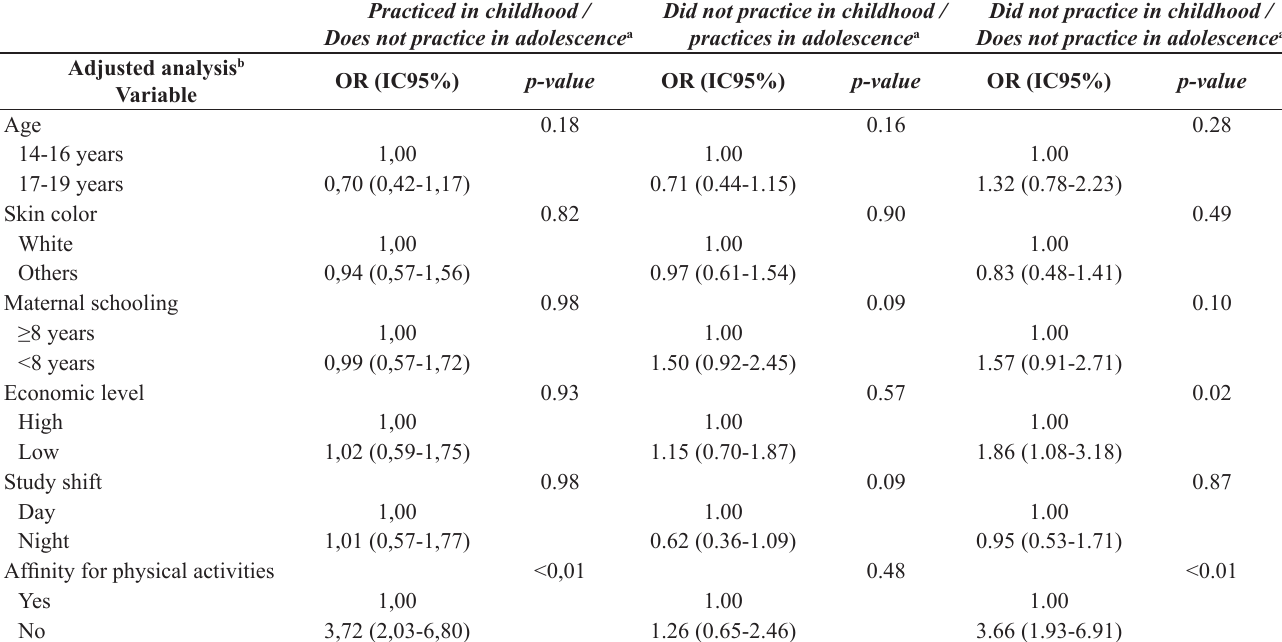
Table 3. Factors associated with sports practice in the period from childhood to adolescence in female students from São José / SC, Brazil Practiced in childhood / Did not practice in childhood / Did not practice in childhood / Does not practice in adolescence a practices in adolescence a Does not practice in adolescence